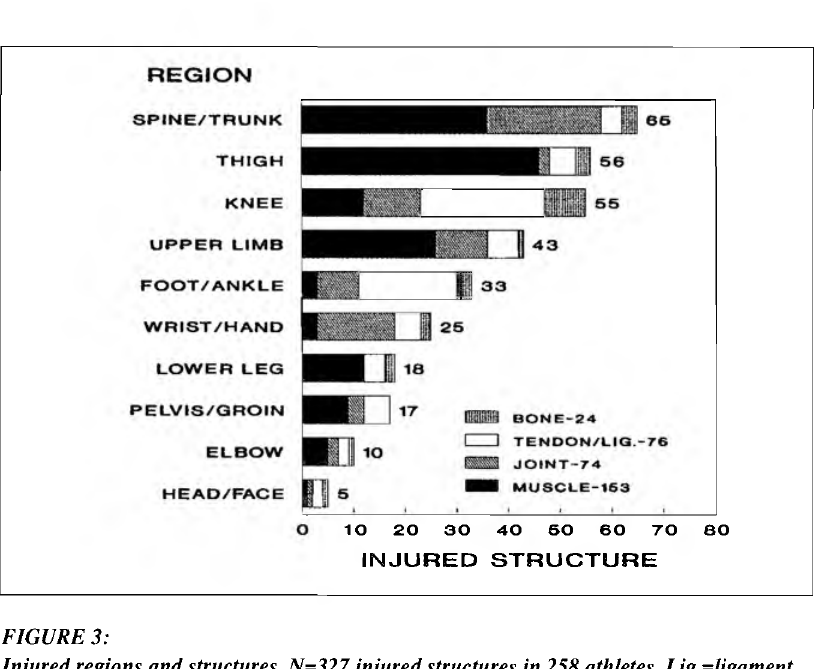
FIGURE 3: Injured regions and structures. N=327 injured structures in 258 athletes. Lig.=ligament.